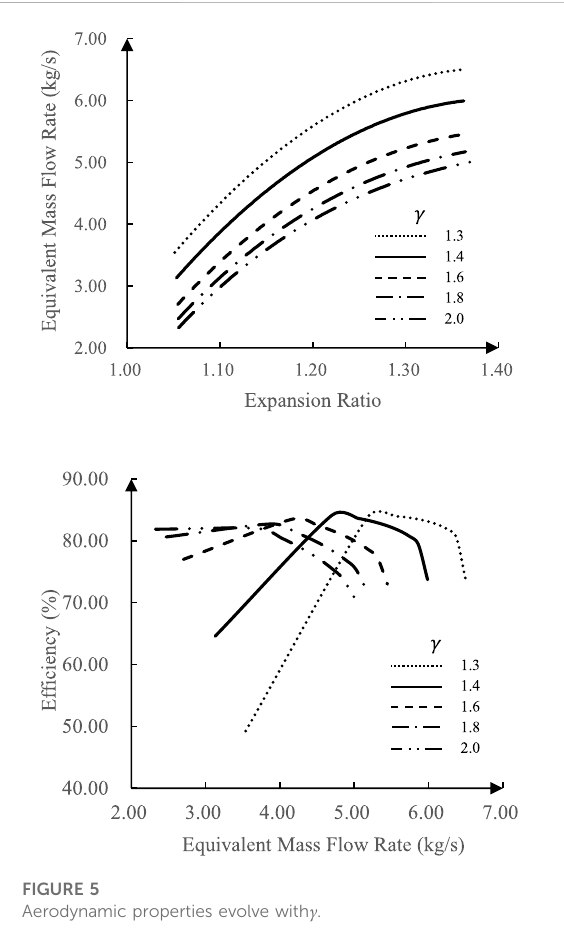
FIGURE 4 Aerodynamic properties evolve with C p .